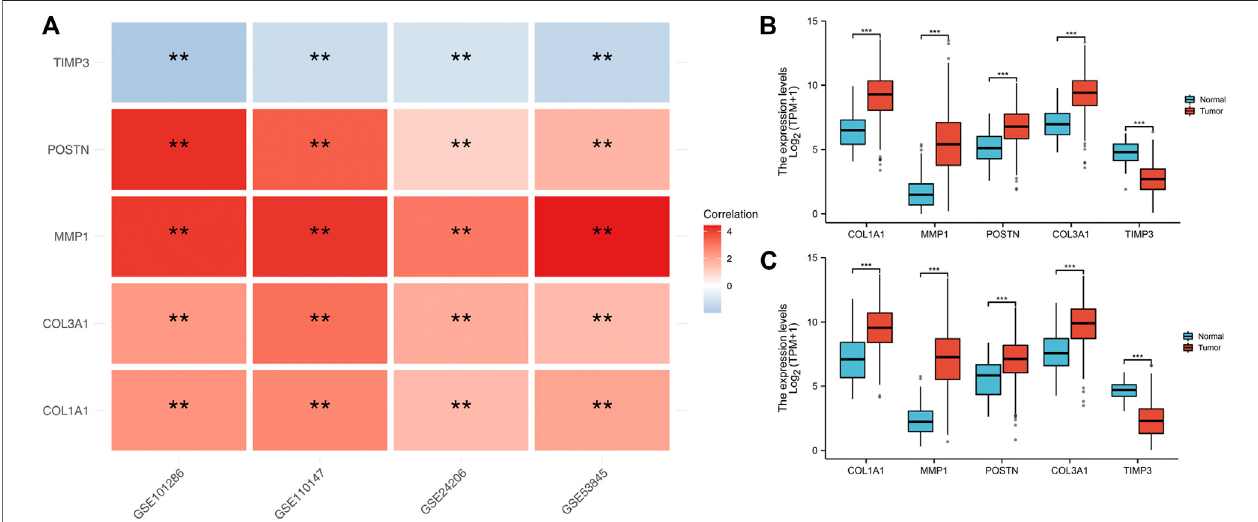
FIGURE3| Expression levelofthe fi vehub genesinIPFand NSCLCpatients.Notes: (A) :Heatmap comparing hubgeneexpression levelsbetweenIPFtissue and normal lung tissue in GSE24206, GSE53845, GSE101286 and GSE110147 datasets, ns = p > 0.05, * = p < 0.05, ** = p < 0.01, *** = p < 0.001.; (B) : The expression difference of hub genes between cancer tissue and normal lung tissue in TCGA-LUAD patients, ns = p > 0.05, * = p < 0.05, ** = p < 0.01, *** = p < 0.001.; (C) : The expressiondifferenceofhubgenesbetweencancertissueandnormallungtissueinTCGA-LUSCpatients,ns= p > 0.05,*= p < 0.05,**= p < 0.01,***= p < 0.001.